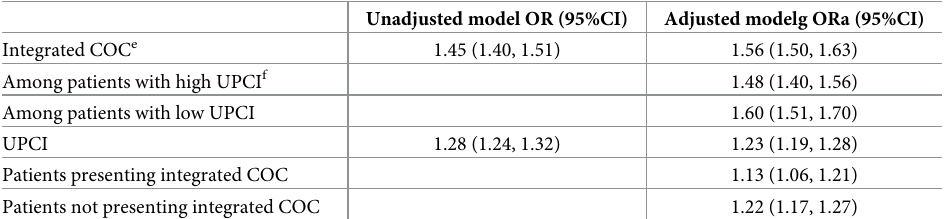
Table 3. Odds ratios (OR a ) and 95% confidence intervals (95% CI b ) for the association of measures of COC c with optimal adherence (PDC d > =